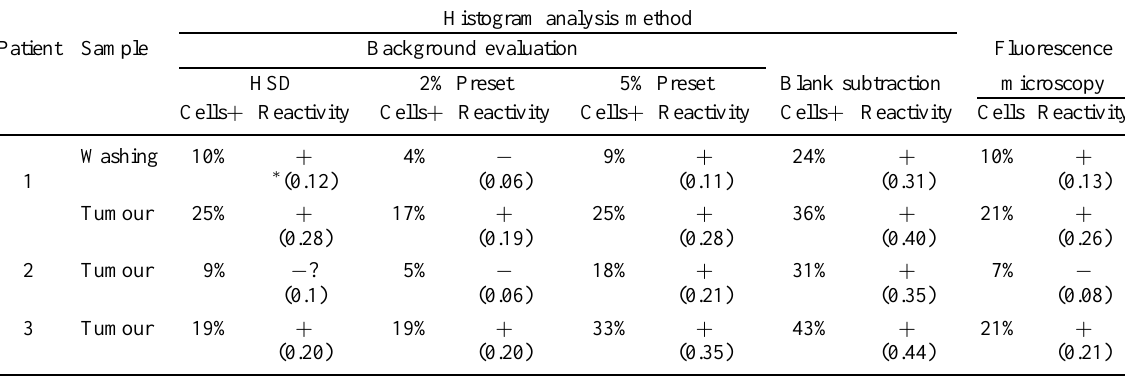
Table 3 Percentage of M344 positive cells assessed by each histogram analytical method and corresponding sample reactivities Histogram analysis